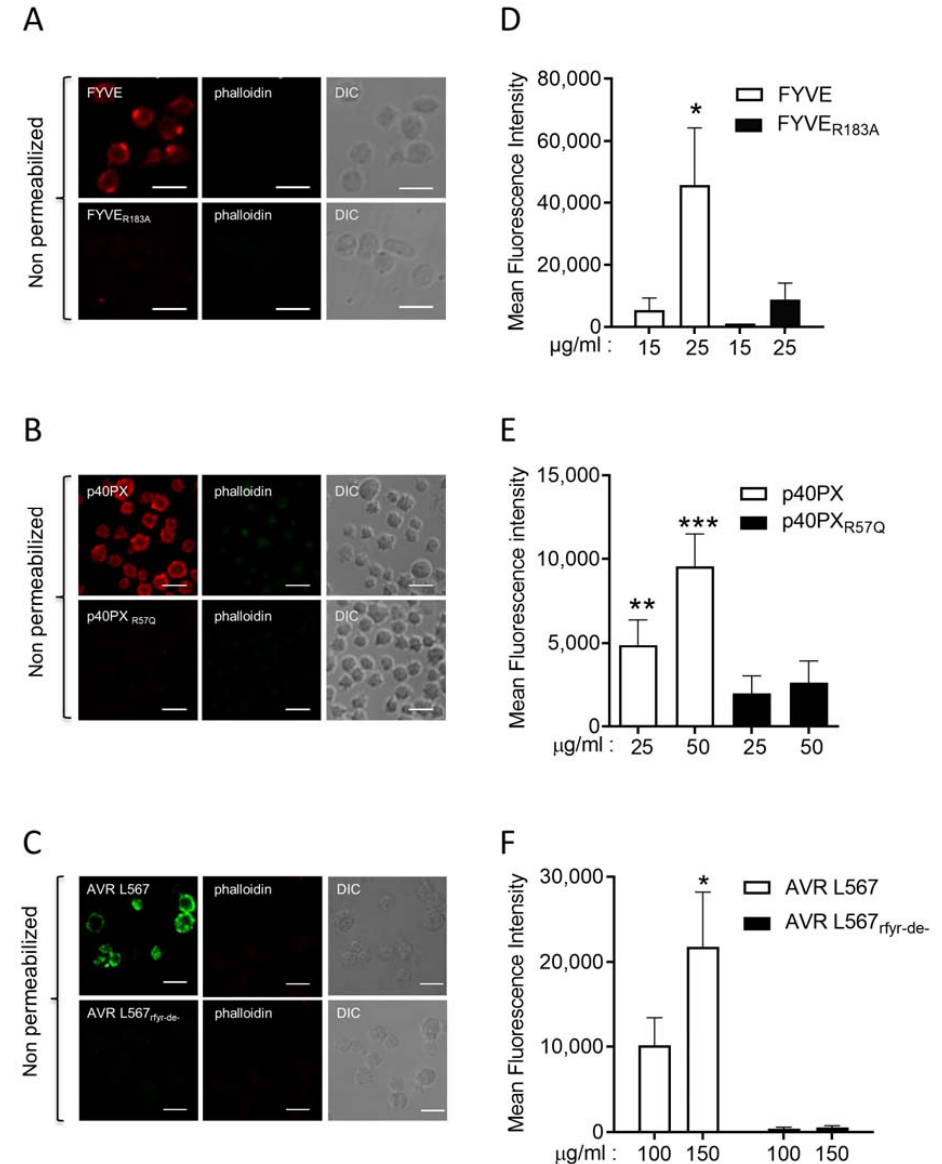
Figure 2. Three unrelated PI3P-binding domains recognize an external pool of PI3P on resting human platelets. Fixed, non-permeabilized, resting human platelets were incubated with three distinct fluorescent specific PI3P probes and their inactive mutants, and analyzed using confocal microscopy, as in Figure 1. Images shown are representative of 5 independent experiments with FYVE or FYVE R183A (25 µ g/mL) ( A ) and p40PX or p40PX R57Q (50 µ g/mL) ( B ), and 3 independent experiments with AVR L567 or AVR L567 rfyr-de- (100 µ g/mL) ( C ). The absence of 488 Alexa-conjugated phalloidin fluorescence confirms the integrity of the plasma membrane. PI3P labeling was also quantified in fixed, non-permeabilized, resting human platelets using the three different probes and their inactive mutants by flow cytometry ( D – F ). Results are presented as mean ± SEM of fluorescence intensity from 5 independent experiments with the FYVE probes and 3 independent experiments with p40PX and AVR L567 probes. Statistical analysis using Wilcoxon test compared each PI3P probe to its mutant used at the same concentration (* p ≤ 0.05, ** p ≤ 0.01, *** p ≤